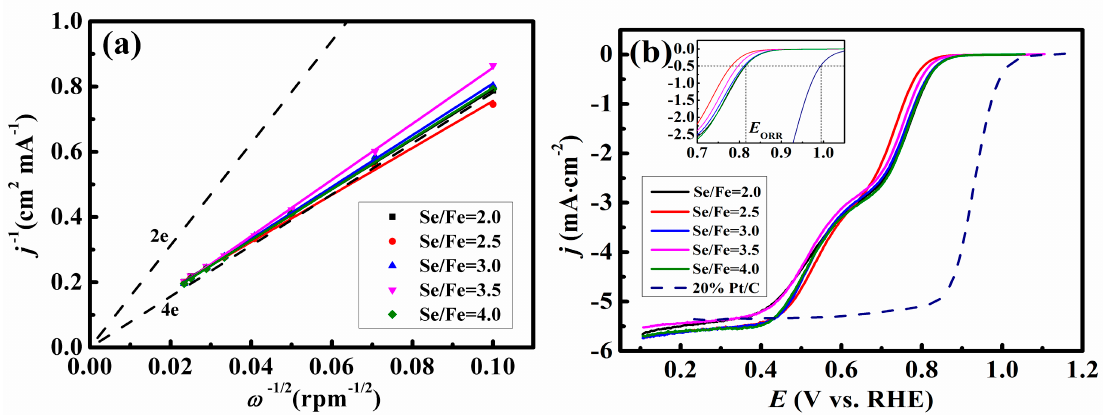
Figure 4. ( a ) Koutecky-Levich plots at 0.3 V; ( b ) RDE polarization curves of Pt/C (dashed line) and FeSe 2 /C (solid lines) prepared with different Se/Fe ratios in O 2 saturated 0.1 mol·L − 1 KOH solutions at 1600 rpm. The inset in ( b ) illustrates the potential corresponding to ORR at the current density of − 0.5 mA·cm − 2 ( E ORR